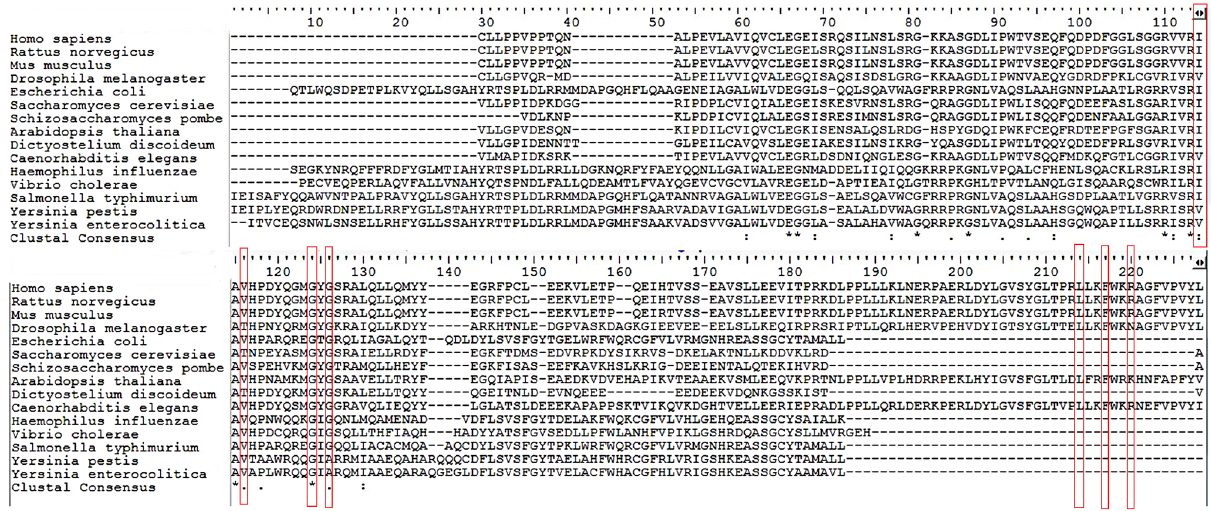
Figure 6. Multiple sequence alignment of the N-acetyltransferase domain showed multiple conserved regions in acetyl-CoA binding site. The most predominant amino acid residues that interact with all six (6) ligands are conserved as illustrated in red